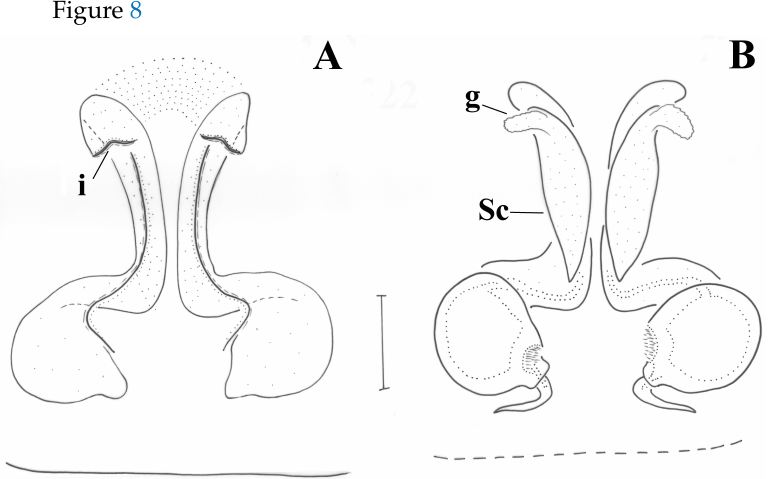
Figure 8. Drassyllus covid n.sp. (holotype). ( A ) Epigyne, ( B ) Vulva. i: introductory orifice, g: gland, Sc: spermathecal